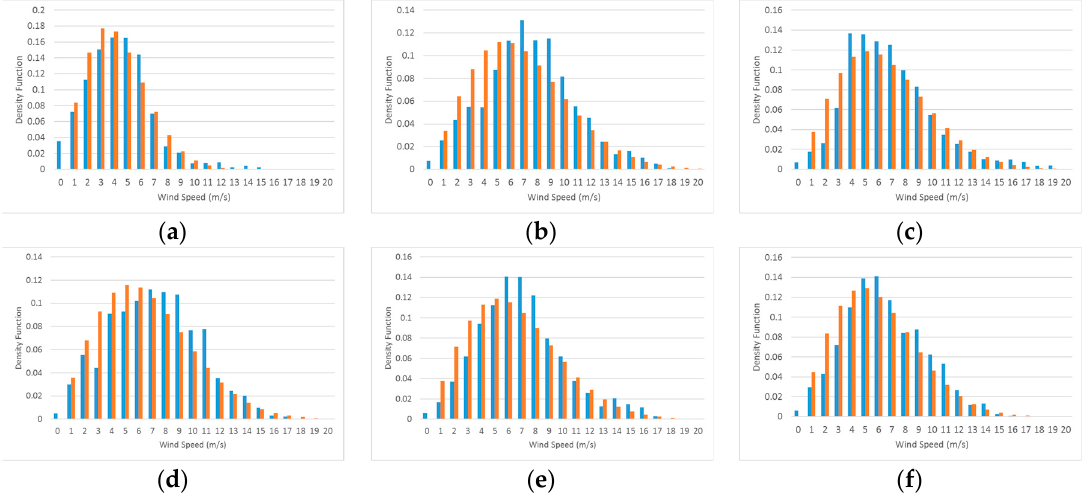
Figure 11. Six groups of samples of normalized histograms of wind speeds, in blue, and fitted Weibull distribution, in orange, for group periods of 15 days each during WS season. Each graph corresponds to the following period ( a ) 01 / 01 / 2010–01 / 15 / 2010; ( b ) 01 / 16 / 2010–01 / 30 / 2010; ( c ) 01 / 31 / 2010–02 / 14 / 2010; ( d ) 02 / 15 / 2010–03 / 01 / 2010; ( e ) 03 / 02 / 2010–03 / 16 / 2010; ( f ) 03 / 17 / 2010–03 / 31 / 2010. 10 Days Ahead